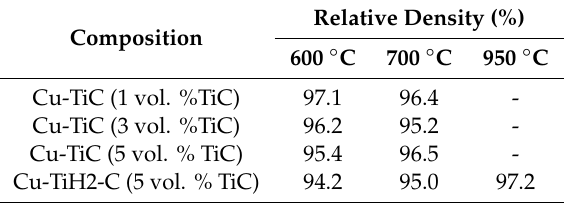
Figure 5. Properties of Cu-TiC composite samples sintered at 600 °C with different vol% TiC: ( a ) relative density of the composites and ( b ) electrical conductivity versus microhardness.